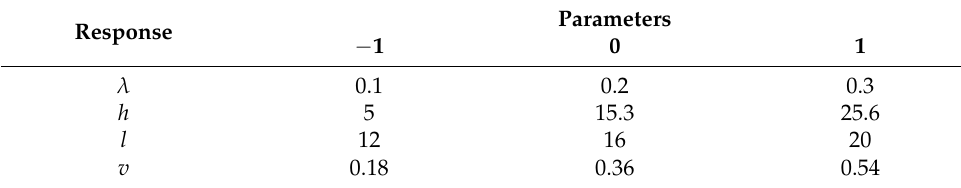
Table 3. Response levels of the four parameters.